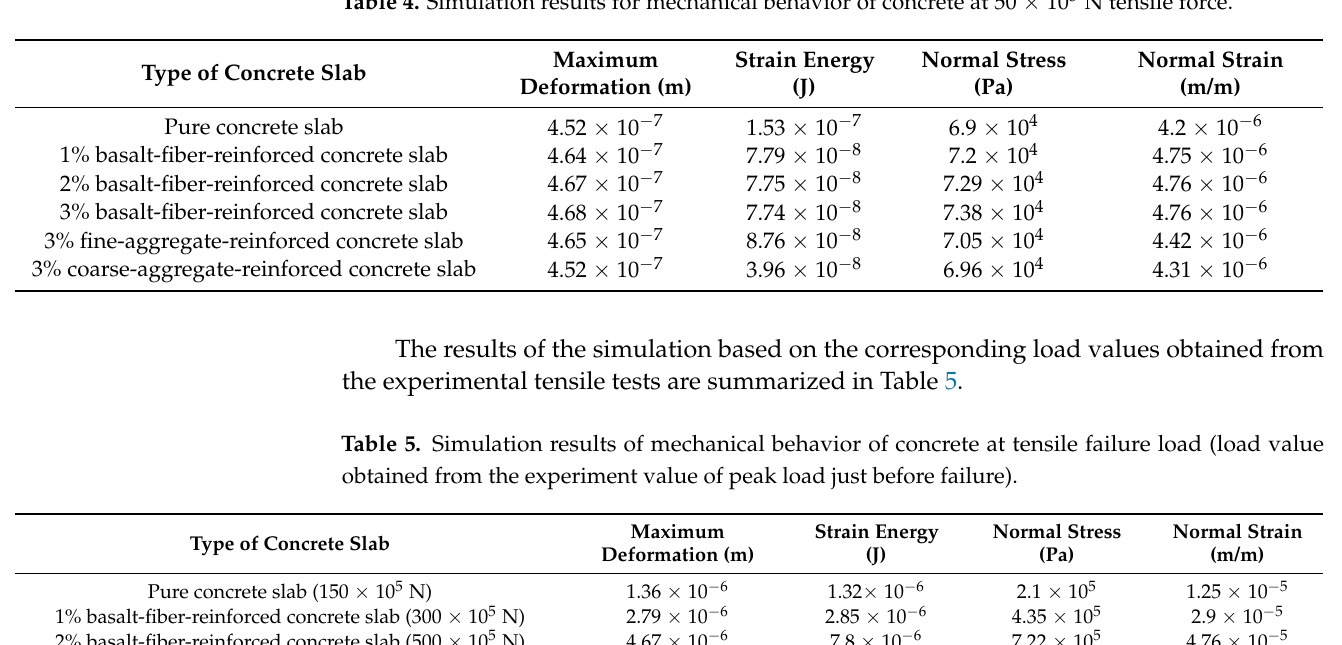
Table 4. Simulation results for mechanical behavior of concrete at 50 × 10 5 N tensile force.